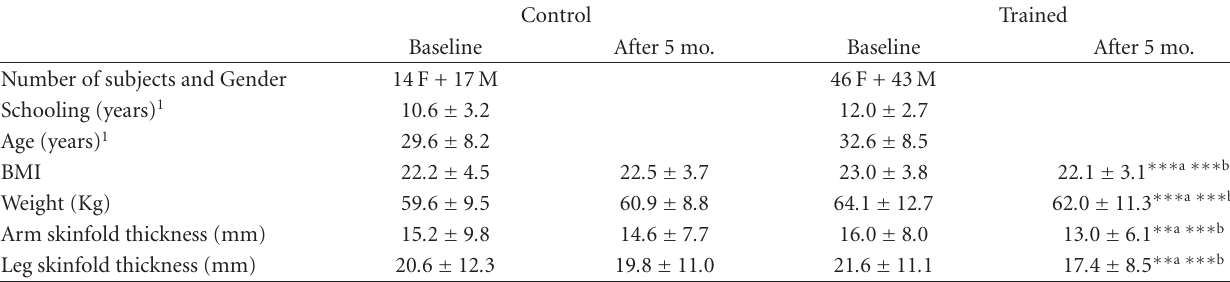
Table 1: Group composition and e ff ects of training on anthropometry.